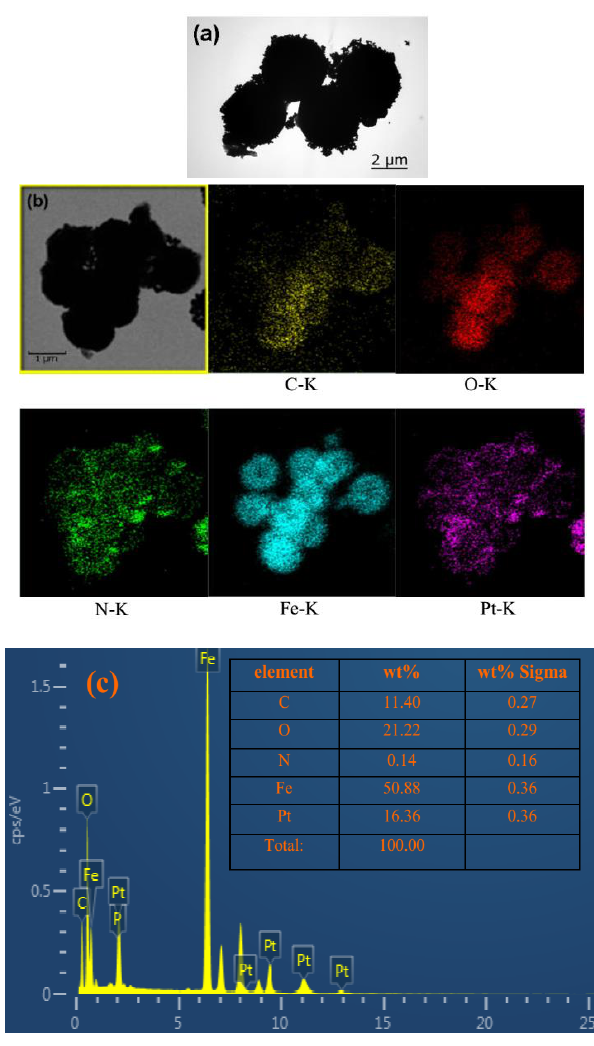
Figure 5. TEM image of Fe 3 O 4 @NC@Pt ( a ) and EDS elemental mappings of C, N, O, Fe, and Pt for Fe 3 O 4 @NC@Pt ( b ), EDS map sum spectrum pattern of Fe 3 O 4 @NC@Pt ( c ).